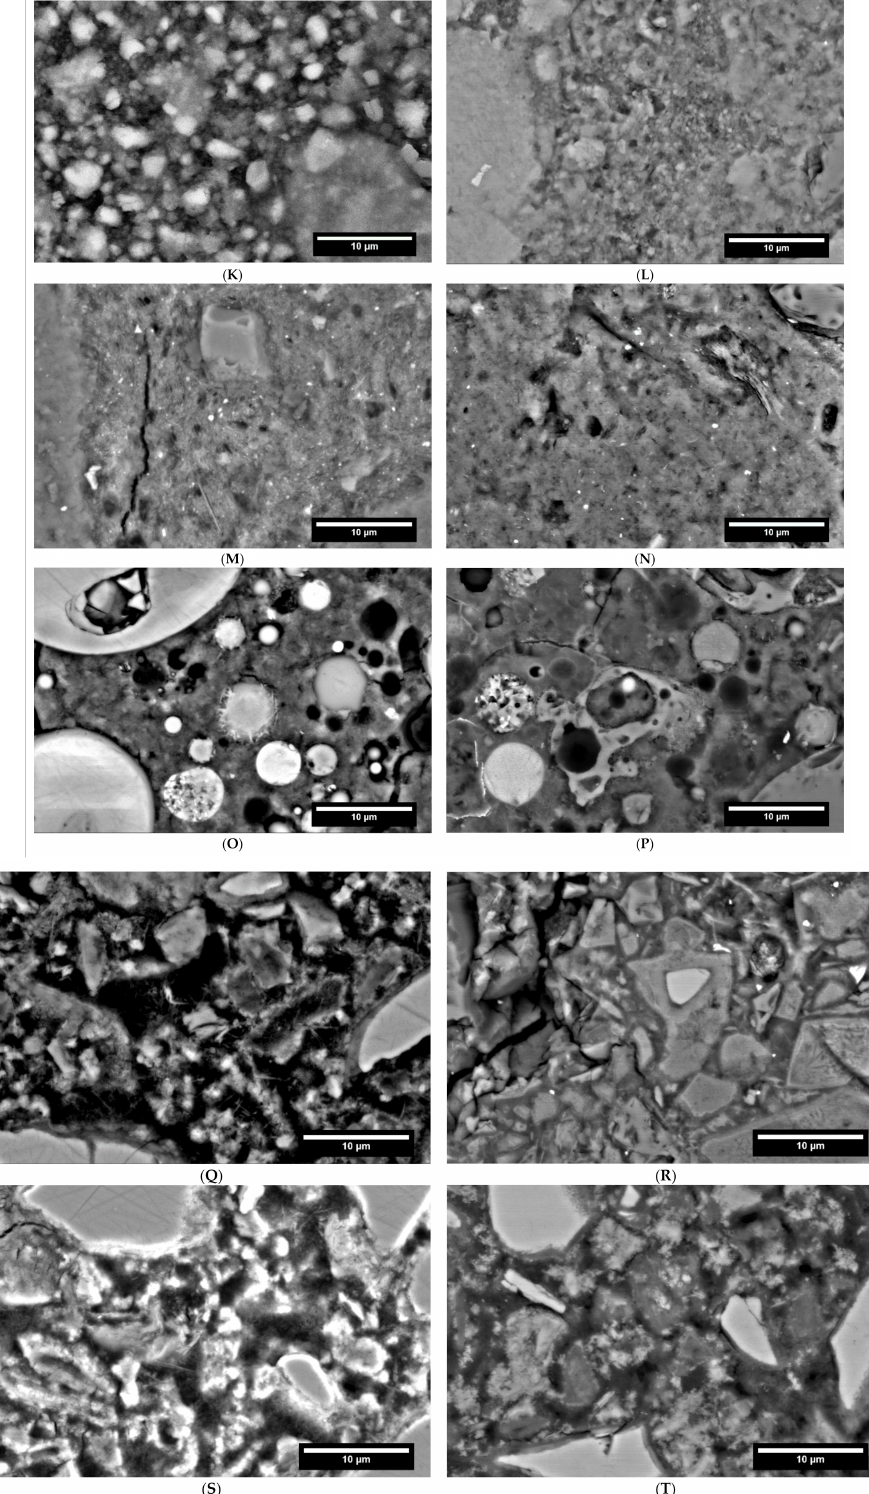
Figure 6. SEM images of the mortar samples at the age of 28 days and carbonated. ( A )